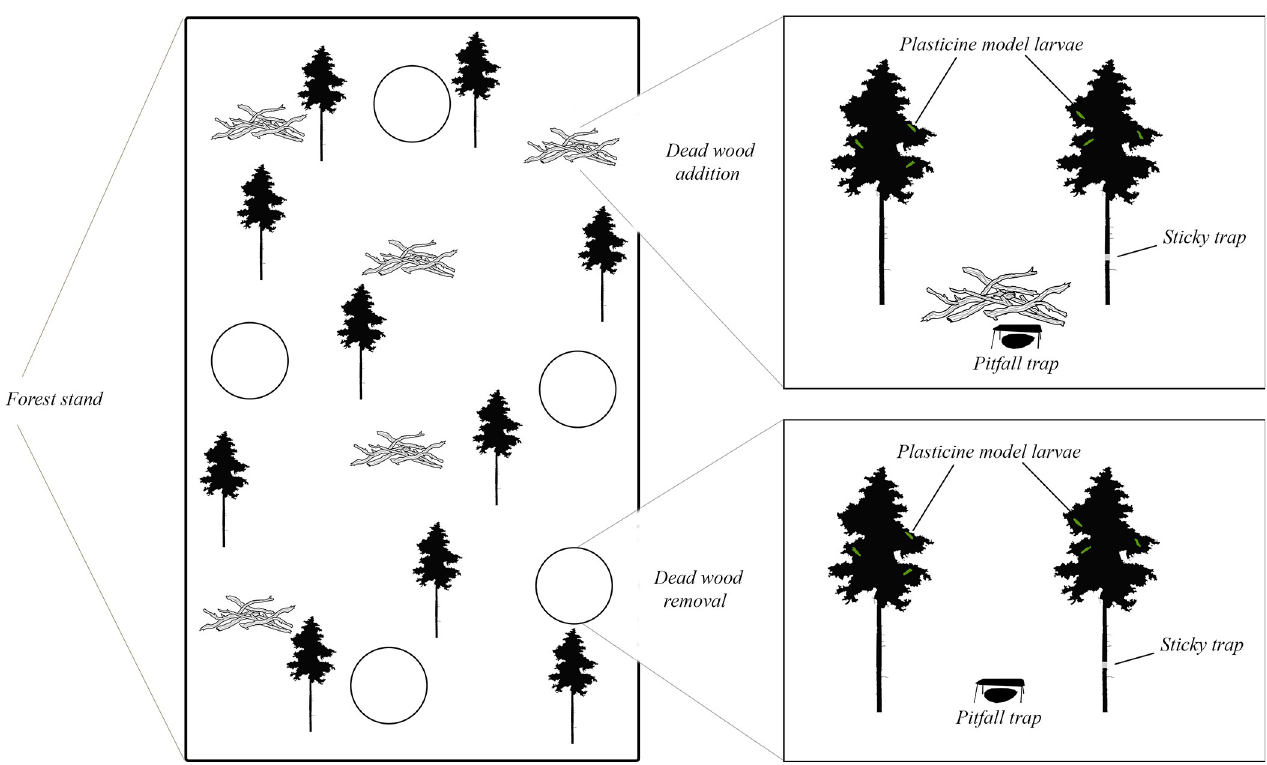
Fig 1. Experimental design testing the effect of dead wood addition/removal on arthropod abundance and diversity as well as predation pressure on plasticine larvae models. Each forest site had five plots where dead wood had been added (pile of branches) and five plots where dead wood had been removed (empty circles). At each plot, three different methods were used to collect data: Pitfall traps, plasticine model larvae and sticky traps. Each plot had two experimental pine trees were attack rates were measured by using plasticine larvae models attached on the tree branches. Sticky traps were attached on one of the two experimental trees at each plot to estimate the effect on attacks when the number of predators walking up the stem were reduced. One pitfall trap was placed in each plot.